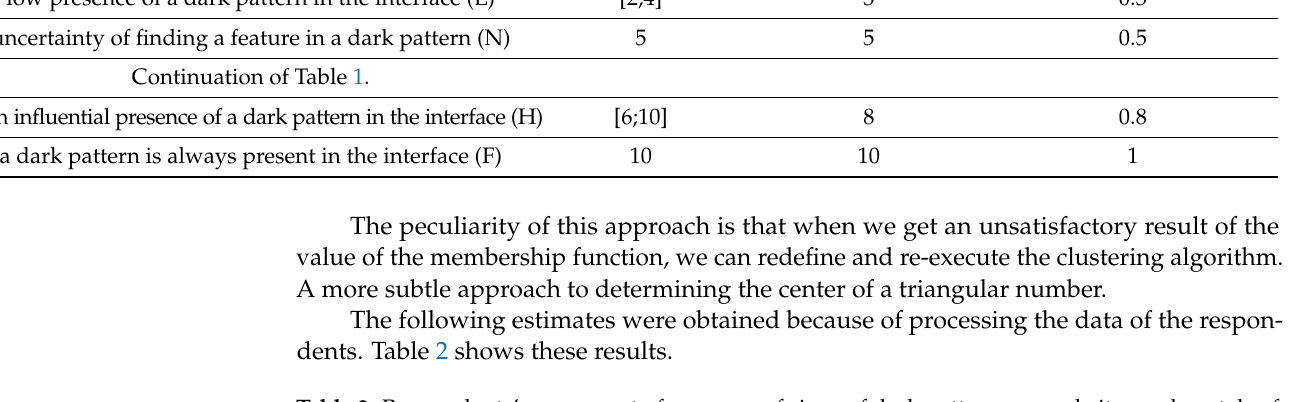
Table 2. Respondents’ assessment of presence of signs of dark patterns on websites and portals of online